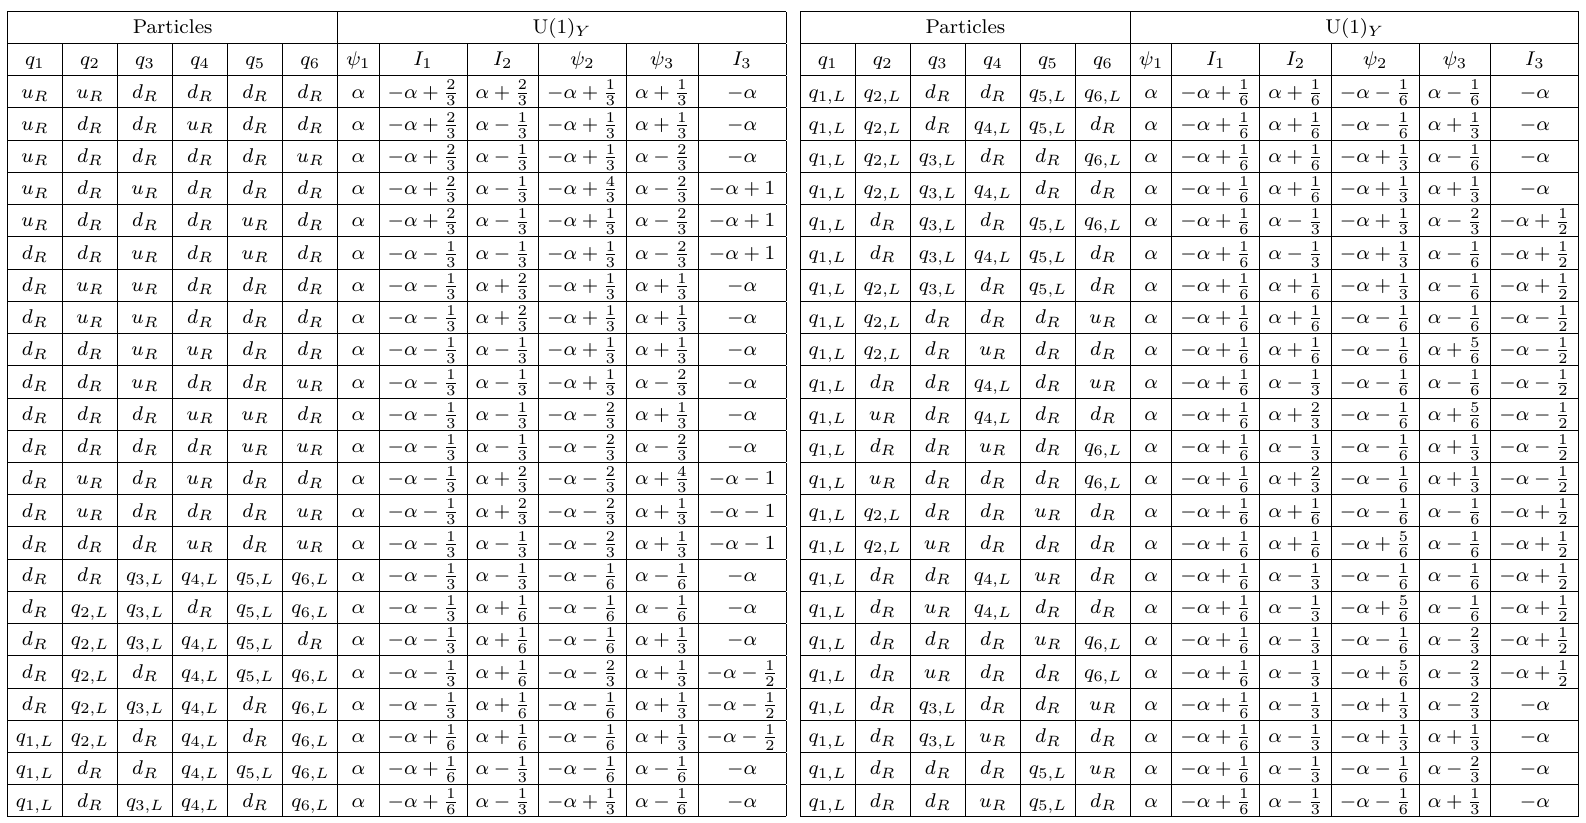
Table 13 . The possible U(1) Y numbers of the fields in